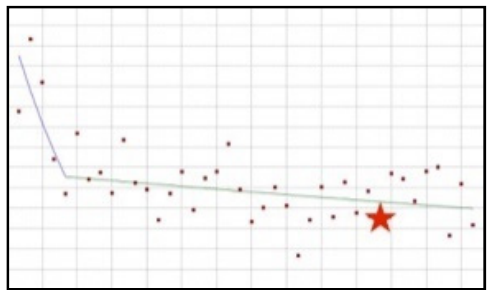
Figure 5. A schematic graph of the frequency of use of pantothenic acid in the respective quarters in the period from the first quarter of 2012 to the fourth quarter of 2021. The star denotes the moment of publication of the resolution concerning the ingredient. The height of placement of the symbol reflects the level of use of the ingredient. Pantothenic acid (Figure